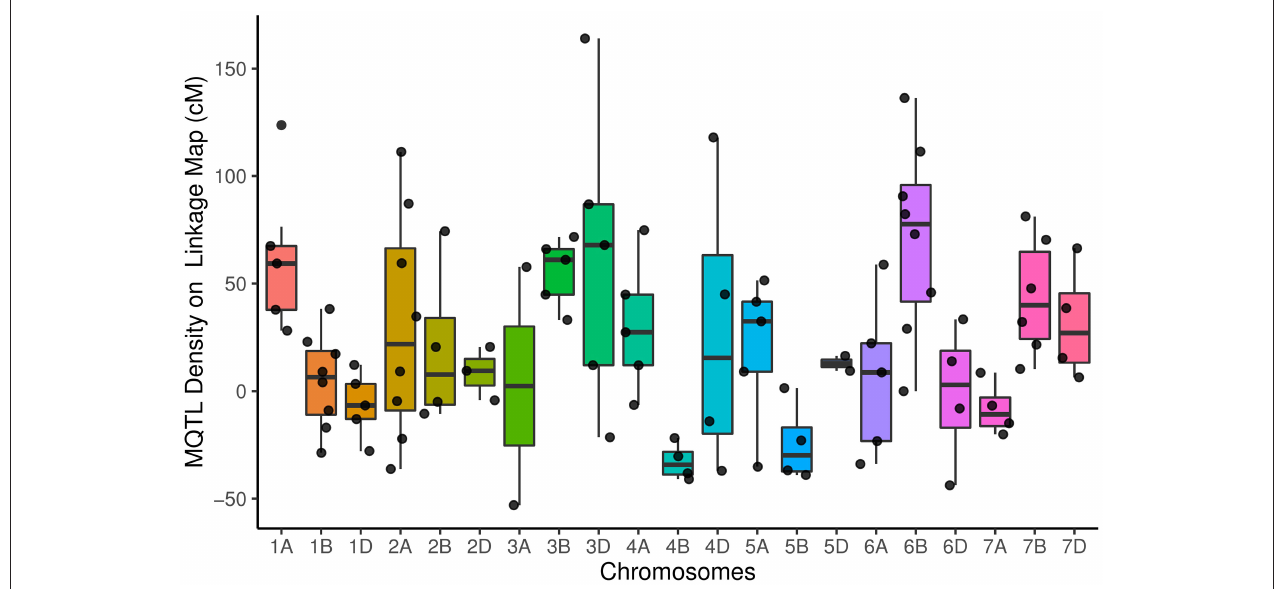
FIGURE 2 | Distribution of meta-quantitative trait loci (MQTLs) for assessed traits on all chromosomes represented as a number of MQTLs per distance (50cM), starting from the centromeric region of each chromosome where it was considered at position 0cM. Each dot represents the exact location of each MQTL.